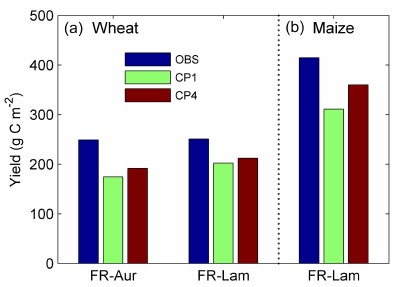
Figure 6. Comparisons of the observed (blue bars) and modeled (green bars for ORC-CP1 and brown bars for ORC-CP4; see Ta- ble 3) harvested crop yields in different sites for winter wheat (a) and maize (b)